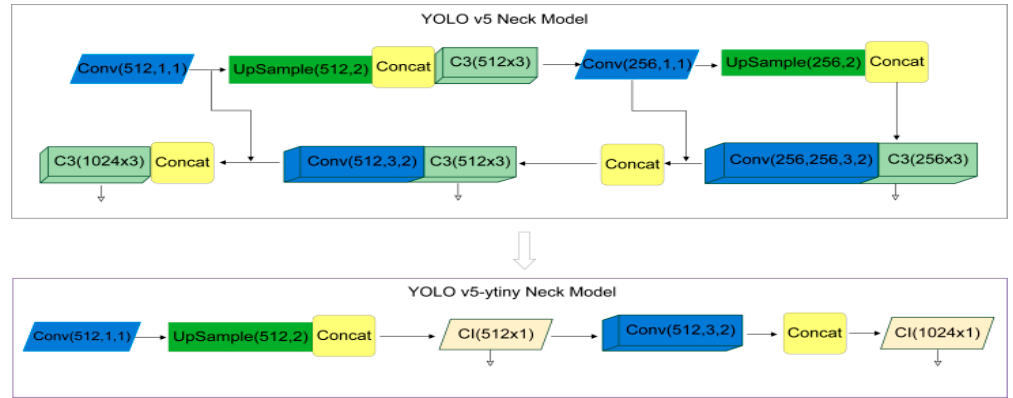
Figure 6. Modify the Neck module to compress the network structure.